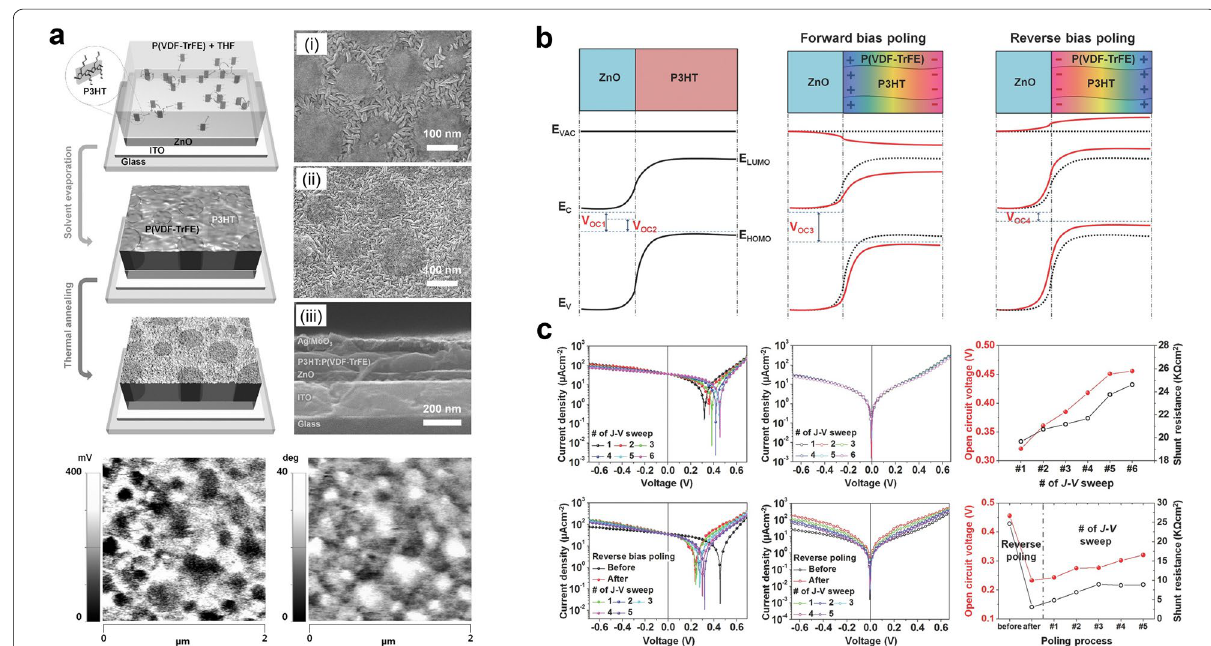
Fig. 9 a Phase separation of P(VDF‑TrFE) and P3HT. b Energy band structure of P(VDF‑TrFE):P3HT/ZnO junction modified by ferroelectric polarization. c Ferroelectric polarization‑affected V OC and J SC (Reproduced from [75] with copyright permission from 2014 John Wiley & Sons)